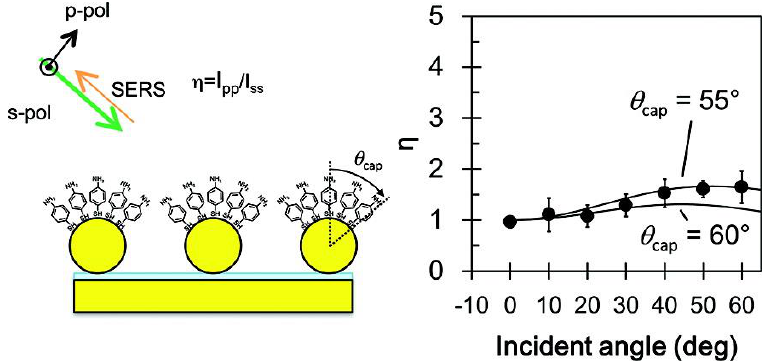
Figure 17. Left: Scheme of the angular-resolved polarized SERS of aminobenzenothiol immobilized on gold nanospheres. Right: Observed depolarization ratio ( η ) profile. The solid lines represent different η profiles simulated for different θ cap angles. Adapted with permission from [113]. Copyright 2012 American Chemical